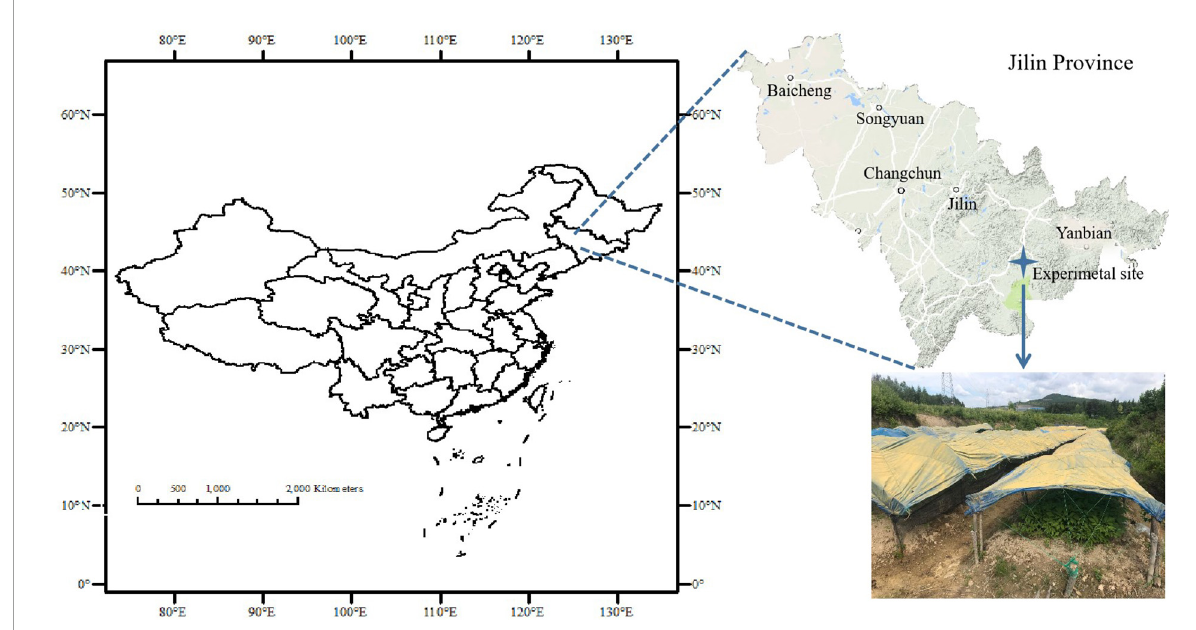
FIGURE1 Site location of the experiment in Fusong County, Jilin Province, Northeast